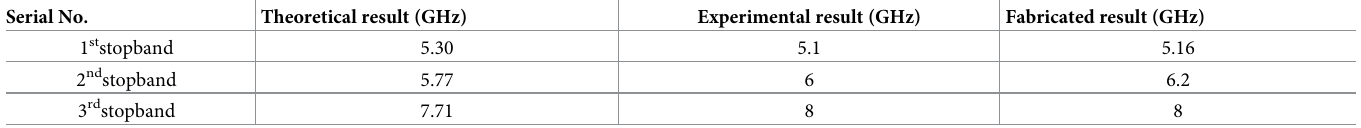
Table 1. The theoretical, experimental, and fabricated outcomes of the stopband frequencies. Serial